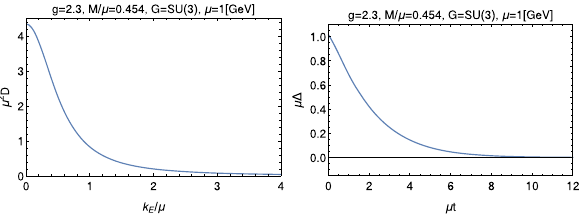
Fig. 8 The same plots as those given in Fig. 7 for a smaller coupling constant g = 2 . 3 with a physical value M /μ = 0 . 454